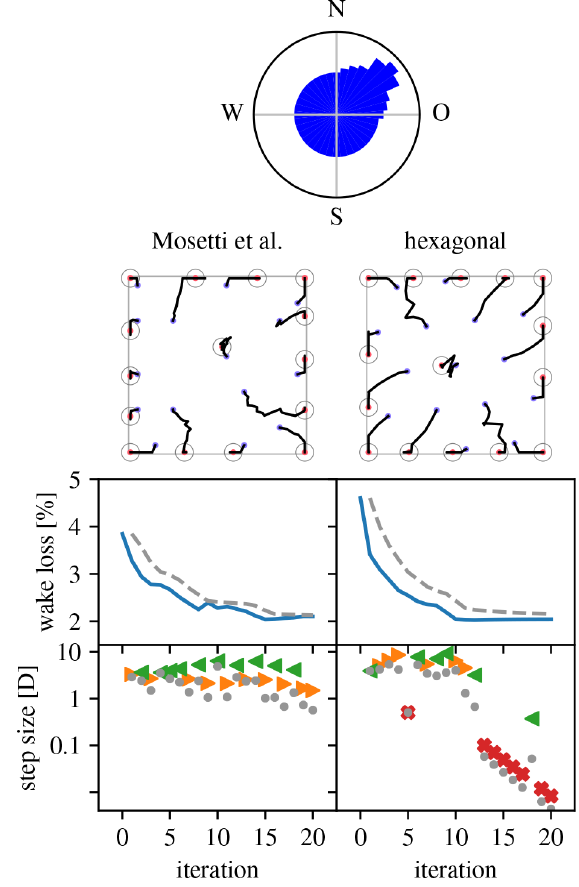
Figure 15. Overview of optimization runs for the Mosetti et al. (1994) wind farm layout problem. (Legend in Table